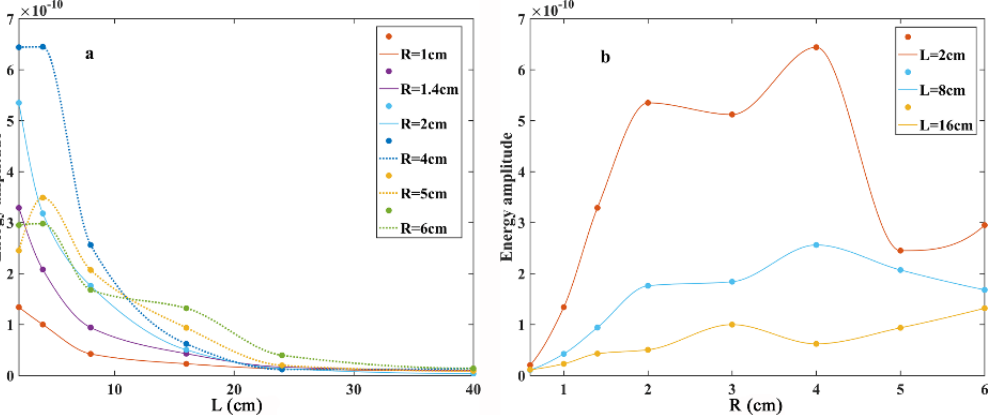
Figure 13. The relationship between the energy of the scattered wave and the cave. ( a ) shows the effect of cave position on the energy of the scattered wave. ( b ) shows the effect of cave radius on the energy of the scattered wave. R represents the radius of the cave . L represents the distance of the cave. Center frequency of source is 10 kHz.